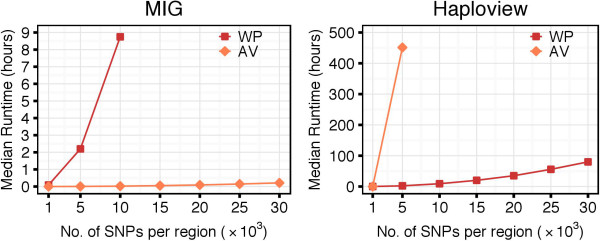
Impact of the WP and AV methods on runtime, when applied to the 1000G dataset. The AV method had negative impact on Haploview runtime: the processing was significantly slower compared to the WP method. However, when combined with MIG, the AV method reduced the computational time from hours to seconds, compared to the WP method.